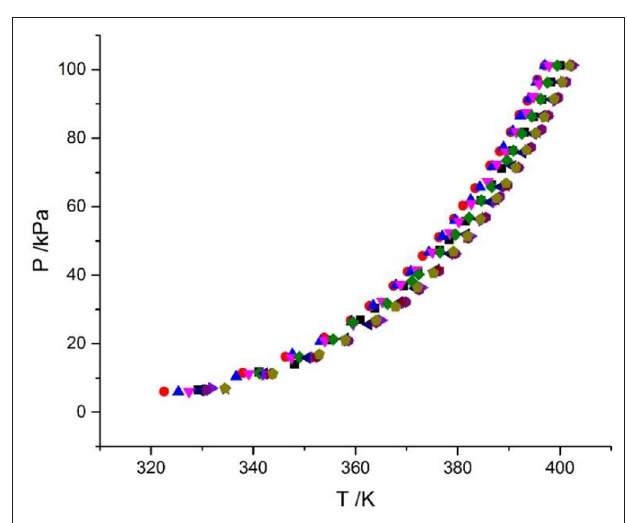
FIGURE 5 | VLE data for the LiCl + CaCl 2 + H 2 O system (Xu et al., 2019a). Symbols ( , ma = 20.08 mol/kg, mb = 0 mol/kg; , ma = 15.63 mol/kg, mb = 1.3 mol/kg; , ma = 10.4 mol/kg, mb = 3.14 mol/kg; , ma = 8.83 mol/kg, mb = 4.07 mol/kg; , ma = 7.46 mol/kg, mb = 4.68 mol/kg; , ma = 5.41 mol/kg, mb = 5.95 mol/kg; , ma = 3.73 mol/kg, mb = 6.73 mol/kg; , ma = 2.43 mol/kg, mb = 7.08 mol/kg; , ma = 1.66 mol/kg, mb = 7.14 mol/kg; , ma = 0 mol/kg, mb = 7.72 mol/kg).